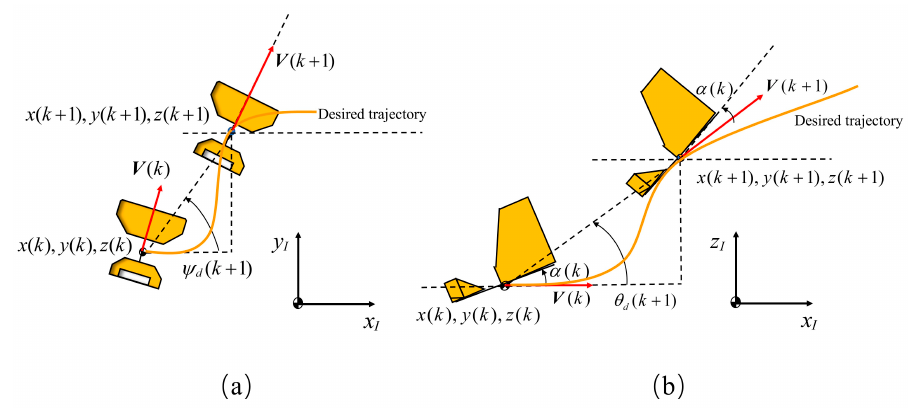
Figure 4. Schematic of ( a ) desired yaw angle, ( b ) pitch angle.